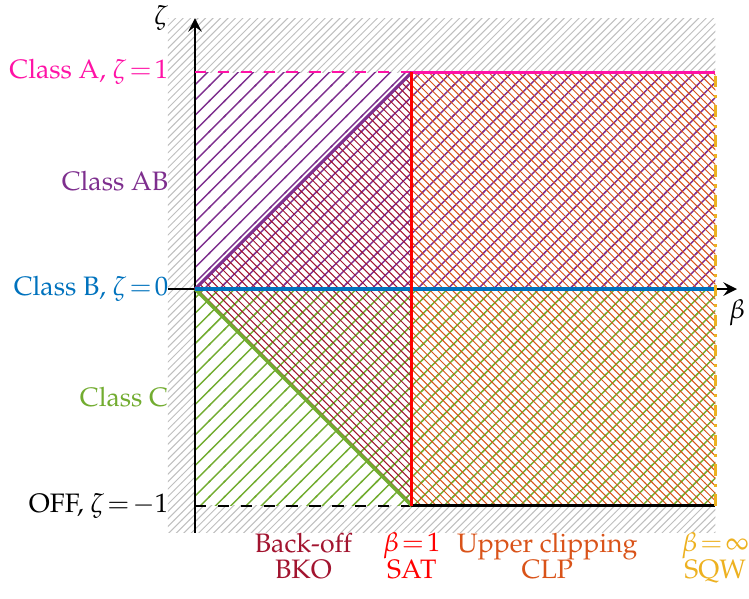
Figure 3. Parameter